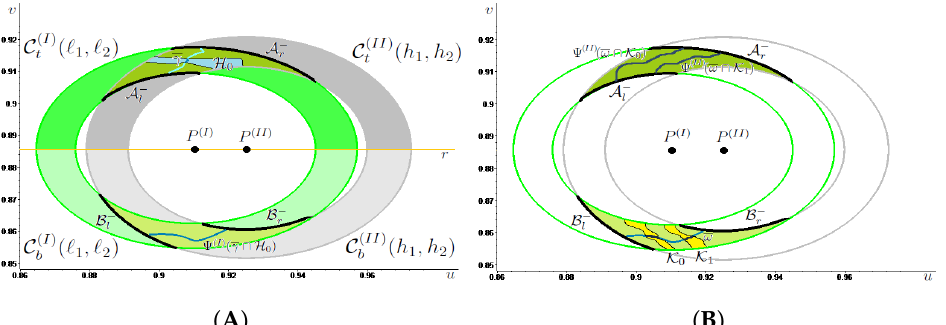
Figure A1. In ( A ), given the linked together annuli C ( I ) ( (cid:96) 1 , (cid:96) 2 ) and C ( II ) ( h 1 , h 2 ) , we draw in orange the straight line r joining the centers P ( I ) , P ( II ) and separating the top sets C colored, respectively, in green and gray, from the bottom sets C respectively in light green and light gray. For A : = C ) , suitably oriented by the choice of their left and right sides, we illustrate in (A) the C ( II ) ( h 1 , h 2 b condition (A1) with m ( I ) = 1 and in ( B ) the condition (A2) with m ( II ) =